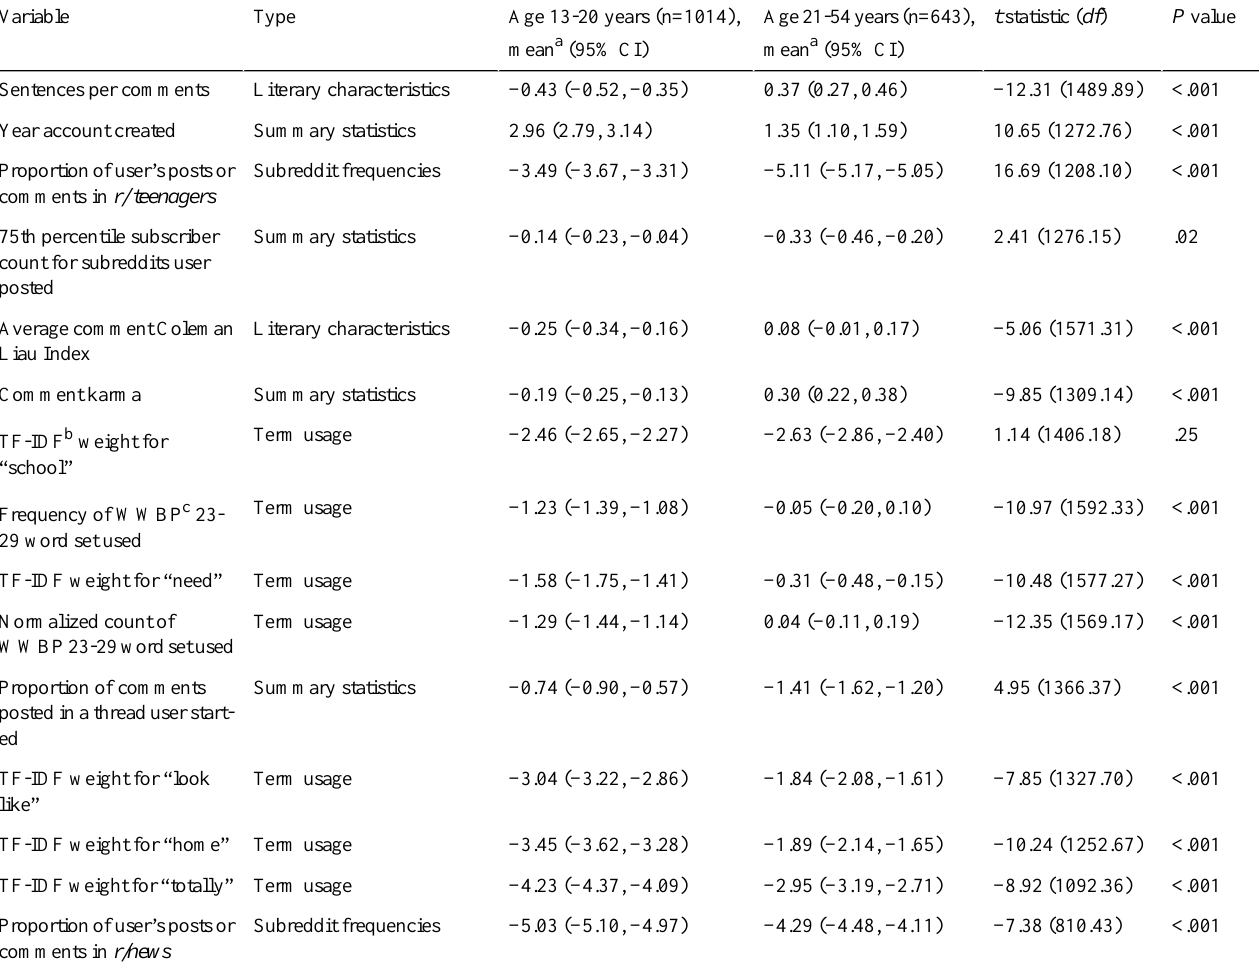
Table 5. Age group comparisons for the top performing variables (by permutation feature importance).